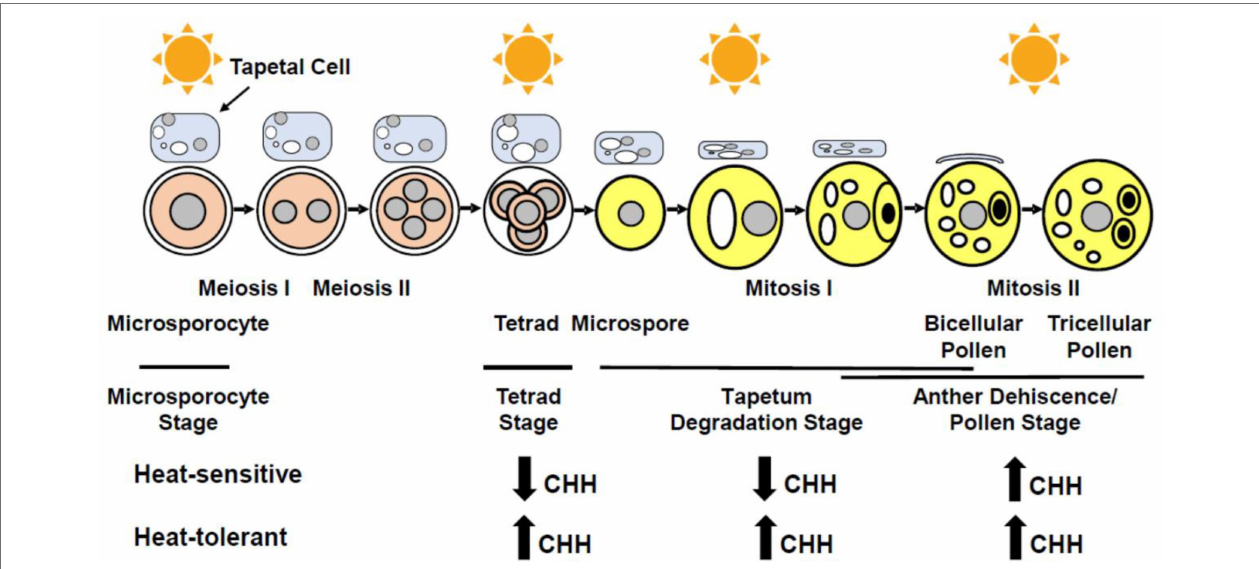
FIGURE 1 | Schematic representation of stages susceptible to heat stress (indicated by sun symbols) during male reproduction and their methylation patterns. CHH methylation is decreased under heat stress at tetrad and tapetum degradation stages in anthers of heat-sensitive plants. CHH methylation is increased under heat stress at tetrad and tapetum degradation stages in anthers of heat-tolerant plants, as well as at the anther dehiscence/pollen stage in anthers of both heat- sensitive and -tolerant plants (H in CHH representing A, T, or